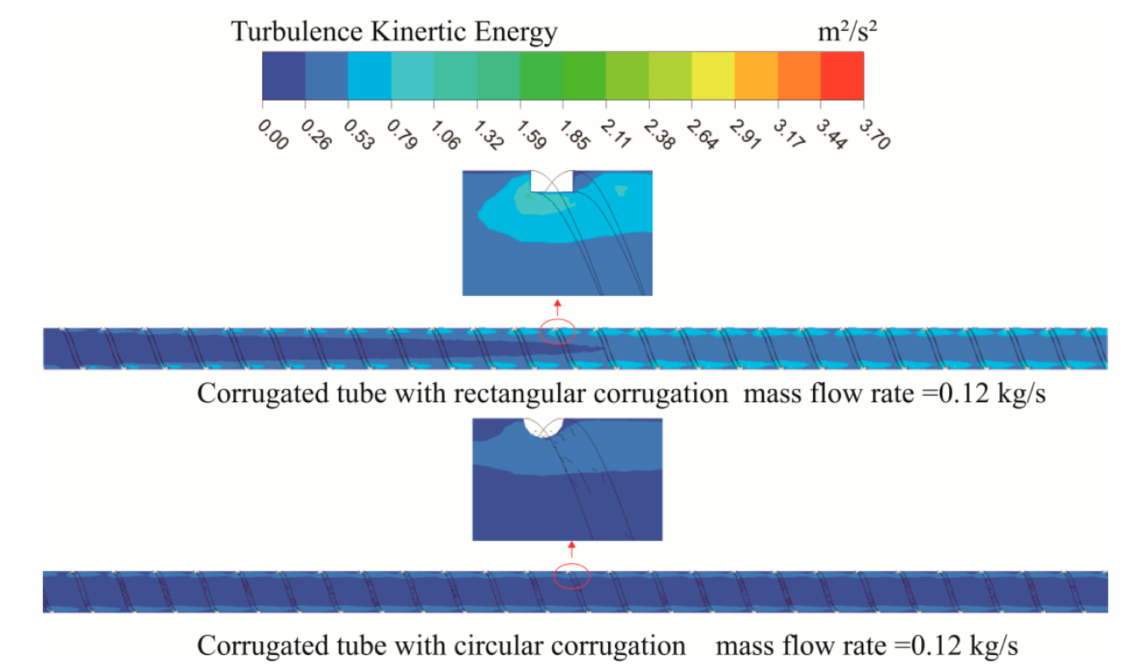
Figure 7. Turbulent kinetic energy of corrugated tubes with circular and rectangular